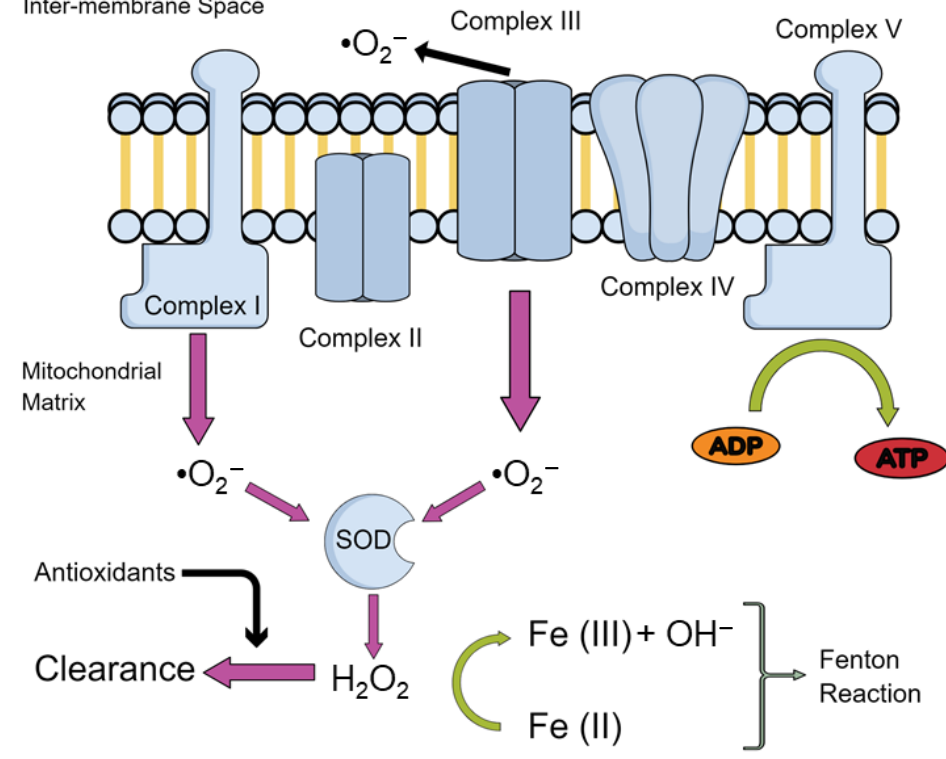
Figure 1. Production of ROS in Mitochondria. An overview of the production of the main reactive oxygen species (ROS) in the mitochondria. Abbreviations: Superoxide ions, • O 2 − ; iron ions, Fe (II)/(III); adenosine diphosphate, ADP; adenosine triphosphate, ATP; superoxide dismutase, SOD; hydrogen peroxide, H 2 O 2